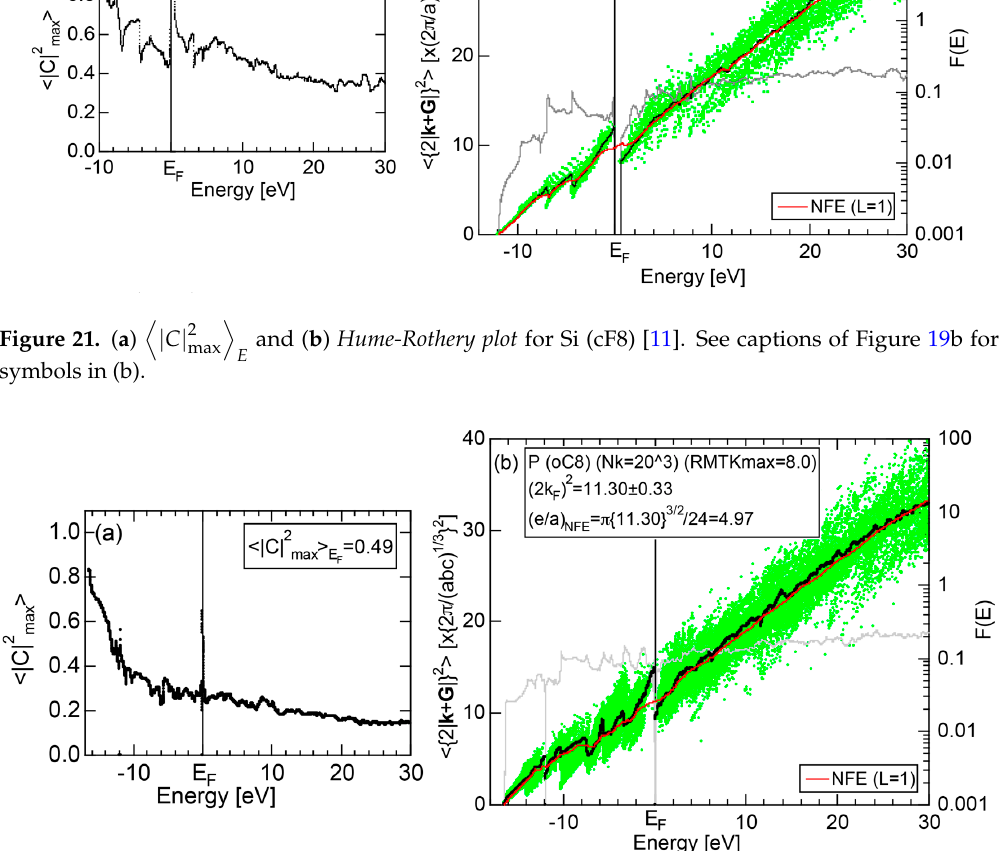
Figure 22. ( a ) C Figure 22. ( a ) C symbols in